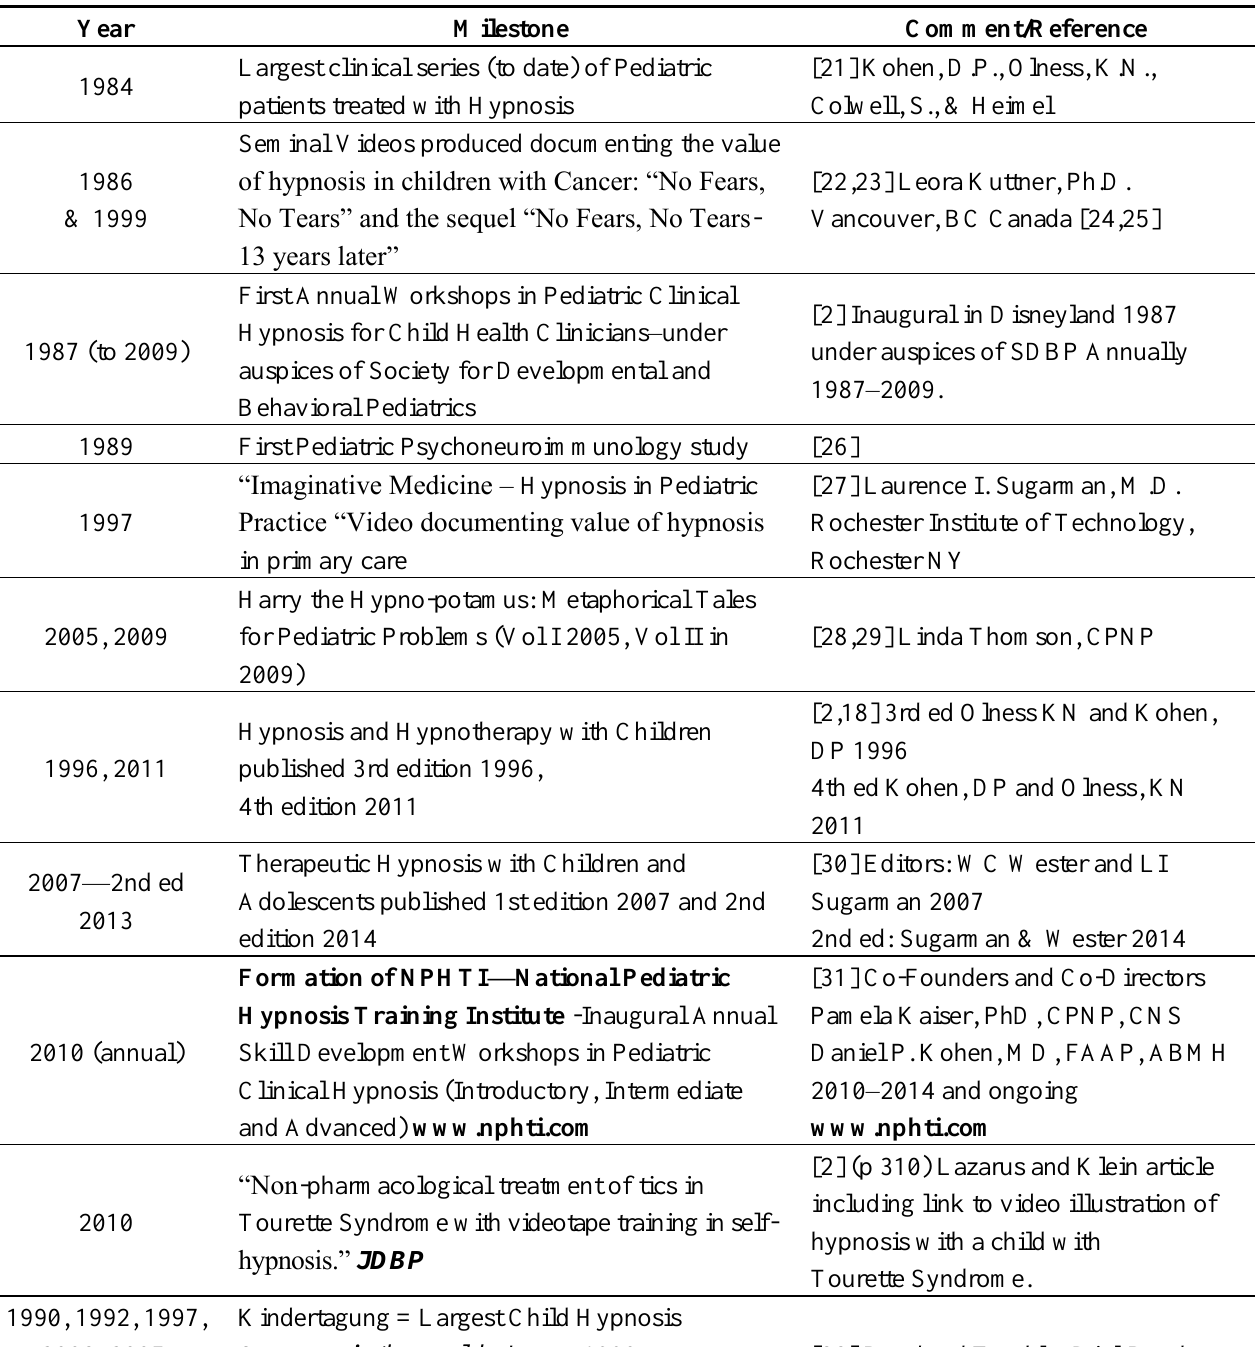
Table 1. Key Milestones in 20th–21st Century Evolution of Pediatric